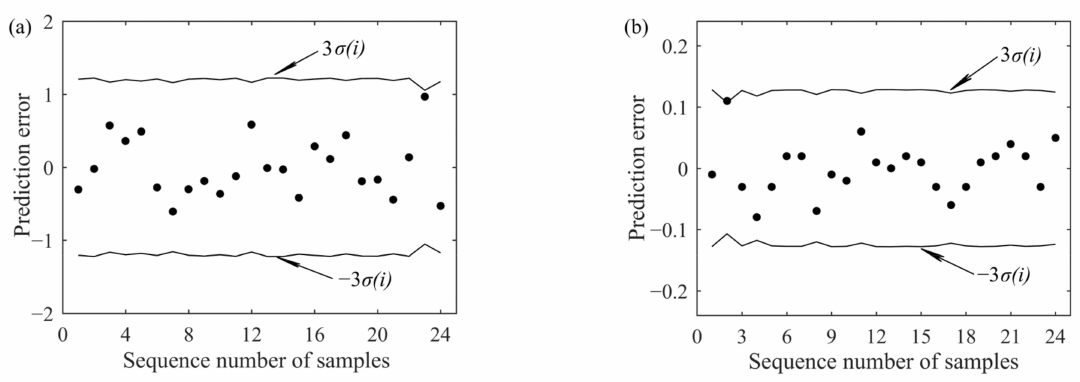
Figure 4. Results of LOOCV with the 3 σ criterion: ( a ) spectrophotometer experiment; ( b ) grating spectrograph